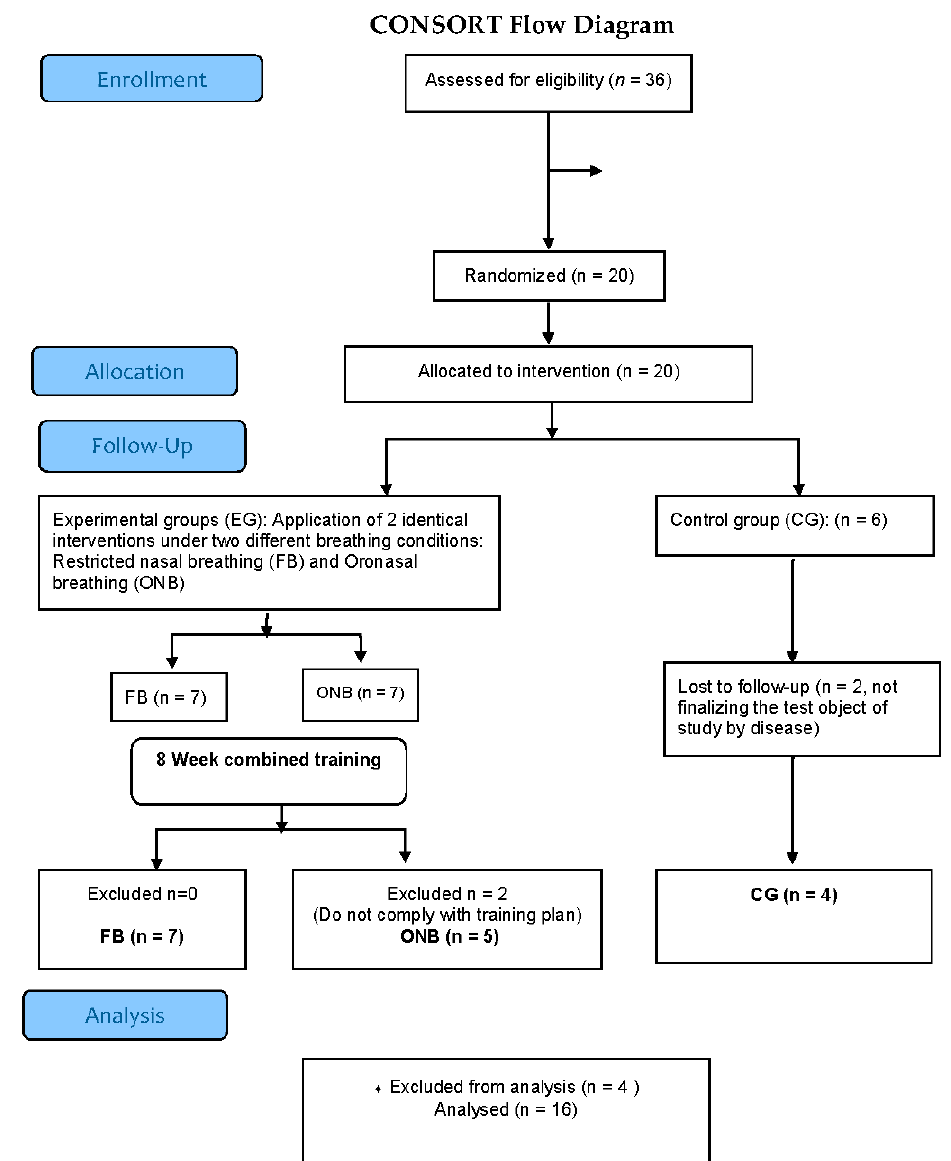
Figure 2. CONSORT Flow Diagram. Flow-chart showing inclusion, randomization and participation throughout the study.